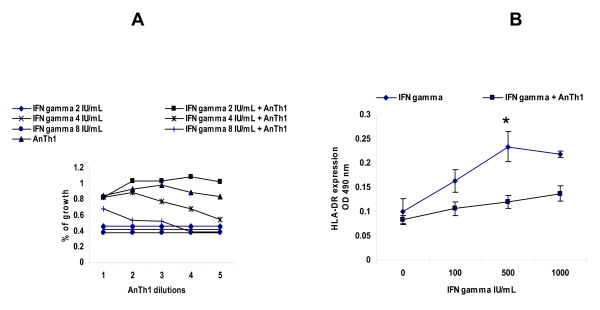
Neutralization of biological activities of rhu IFN-γ by recombinant chimeric protein. Panel A: Inhibition of antiproliferative activity of IFN-γ. The inhibition of antiproliferative action of 4 IU/ml of IFN-γ by 50 μg/ml AnTH1 proved to be statistically different (p < 0.05) by the Kruskal-Wallis test. The data are results from 3 independent experiments. The dilutions tested for the antagonist were: 1 (1:4), 2 (1:8), 3 (1:16), 4 (1:32), and 5 (1:64). The OD 580 nm of cells without IFN-γ at the beginning of the experiment was 0.139 and after 72 hours on culture was 1.068. Panel B: Inhibition of the IFN-γ induced HLA-DR by the AnTh1. The inhibition of IFN-γ (500 IU/mL) HLA-DR stimulation by 1.5 μg/ml AnTh1 proved to be statistically different (p < 0.05) by the Kruskal-Wallis test. The data are the results from 3 independent experiments. The amount of IFN-γ was denoted as IU of antiviral activity, where 1 IU is defined as the inverse of the dilution that conferred 50% protection to the monolayer of cells infected with a virus.